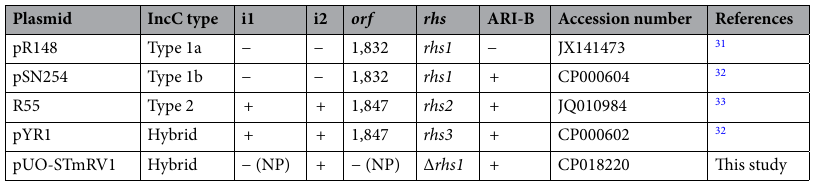
Table 2. In silico PCR-typing of pUO-STmRV1. NP, regions surrounding the i1 and orf locations are not present; Δ rhs1, only 1,317 bp of the 3’-end of rhs1 (4,254 bp) are present. Based on 28 .